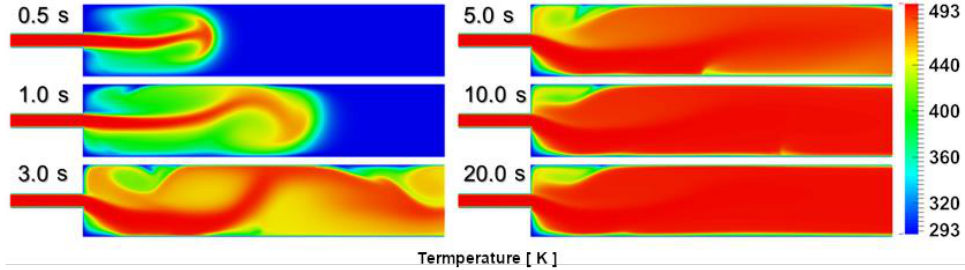
Figure 5. The temperature fields at different time steps with considering the gravity and using the proposed particle flux model.